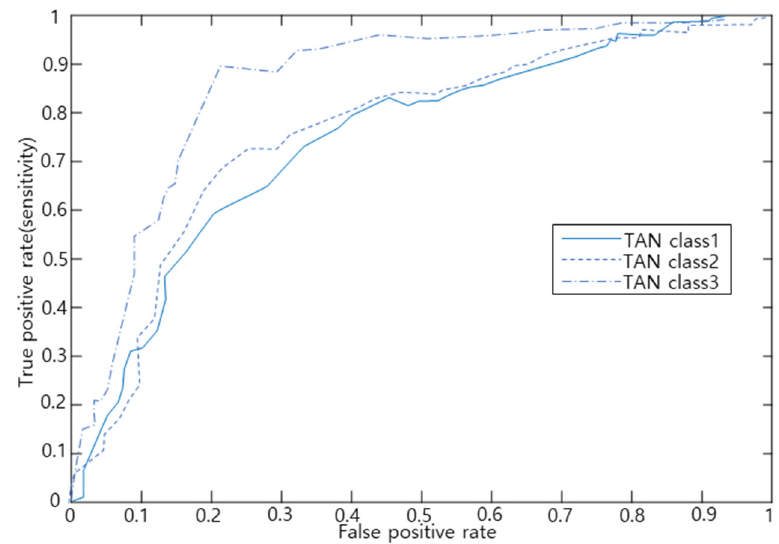
Figure 6. ROC curve of RORC severity prediction model. Therefore, the TAN model has a highly accurate classification prediction power for fatal accidents. The classification prediction power for serious and slight accidents is lower than that for fatal accidents, but these are still judged to be relatively